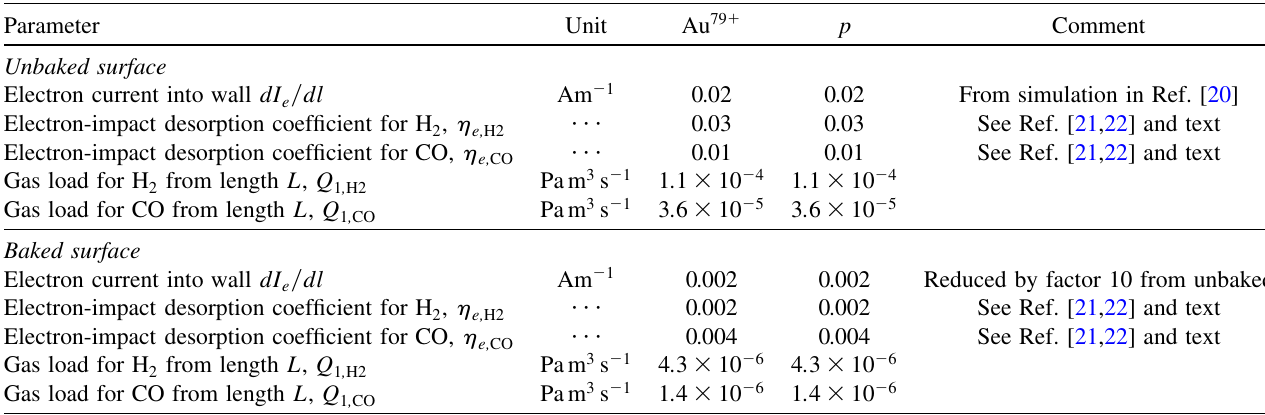
in the warm vacuum regions due to electron-impact desorption from electron clouds. 1